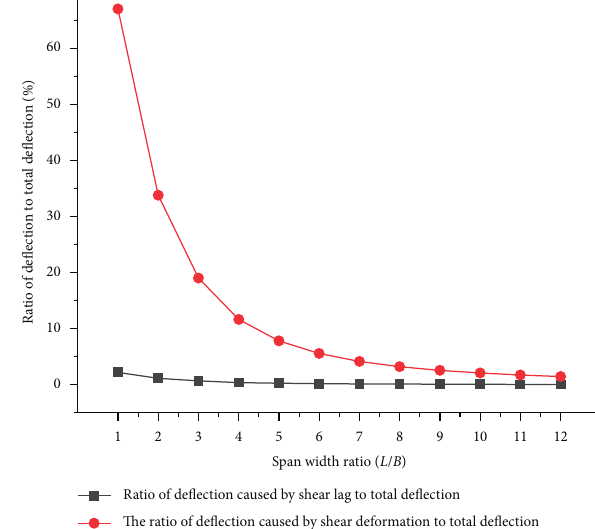
Figure 15: Influence of span width ratio on the deflection of the single box and single cell box girder under uniform distribution load